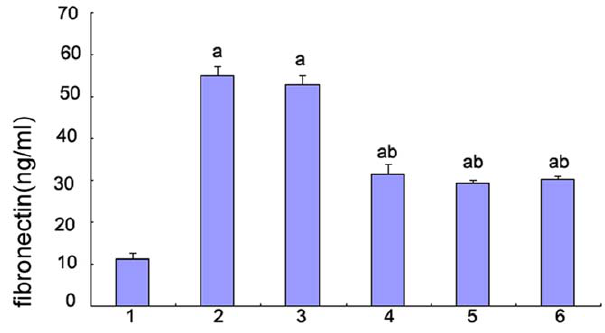
Figure 9. Fibronectin synthesis in HK-2 cells by ELISA. Fibronectin was measured by ELISA of the HK-2 cells in 5.5 mM glucose (lane 1), 30 mM glucose(lane 2), 30 mM glucose + Cont siRNA(lane 3), 30 mM glucose + p38 siRNA for 24 h(lane 4), 30 mM glucose + p38 siRNA for 48 h(lane 5) and 30 mM glucose + AP-1 inhibitor(lane 6). Values represent the mean 6 SD, a P , 0.05 vs. 5.5 mM glucose, b P , 0.05 vs. 30 mM glucose.